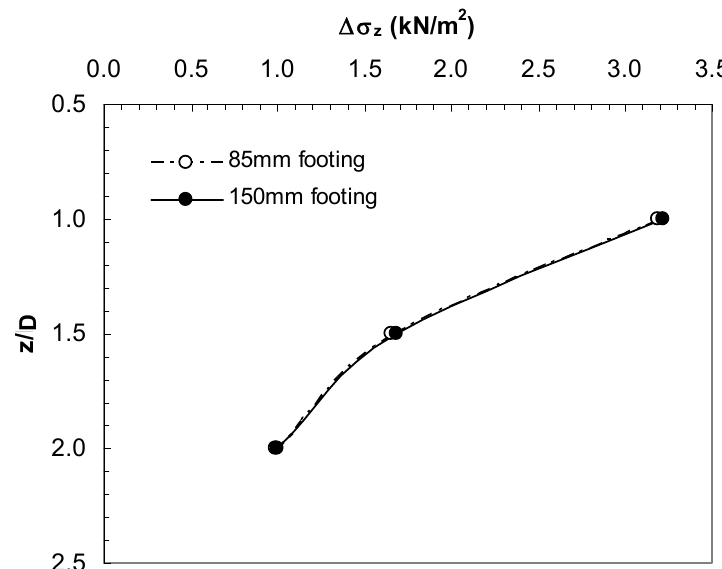
Figure 11. Vertical stress values obtained from 2DM analysis.